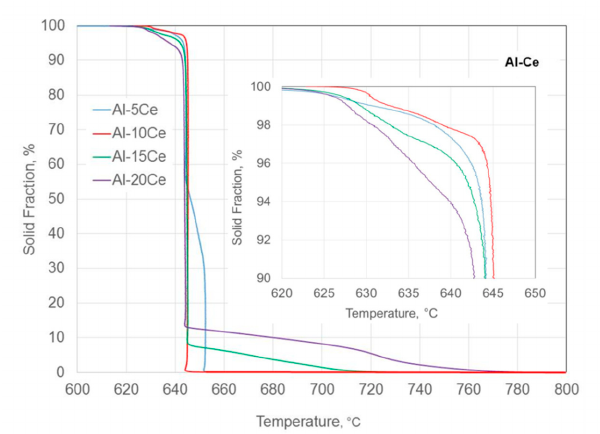
Figure 4. Experimental solid fraction versus temperature, determined based on the cooling curves, measured in the UMSA apparatus. The inset shows the non-equilibrium solidification of the small liquid fraction below the eutectic temperature.